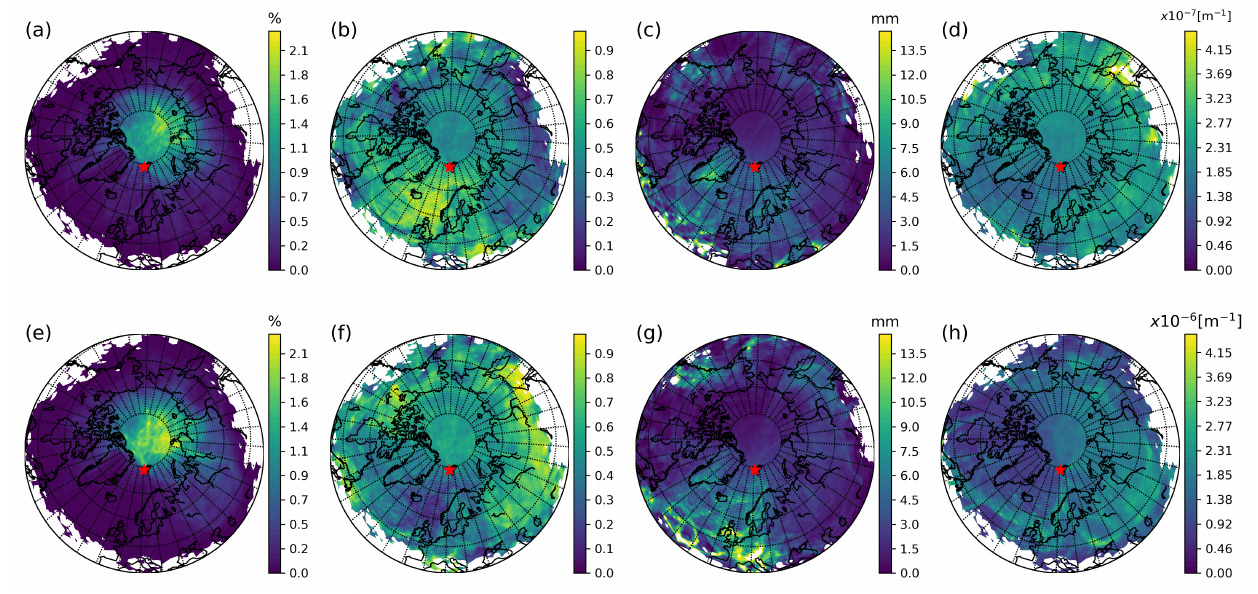
Figure 3. For the ‘Polluted’ cluster group in the first row, the parameters are shown for the first Subgroup 1 and in the second row in the same order for the second Subgroup 2. The red star marks the location of Zeppelin Observatory. The transport probability function P i , j [%] ( a , e ); the ratio transport function R i , j ( b , f ); accumulated precipitation [mm] ( c , g ); and the absorption coefficient at Zeppelin in [m − 1 ] ( d , h ). The absorption coefficient corresponds to the eBC concentration via the constant MAC value. Note the magnitude for the absorption coefficient is stated above the